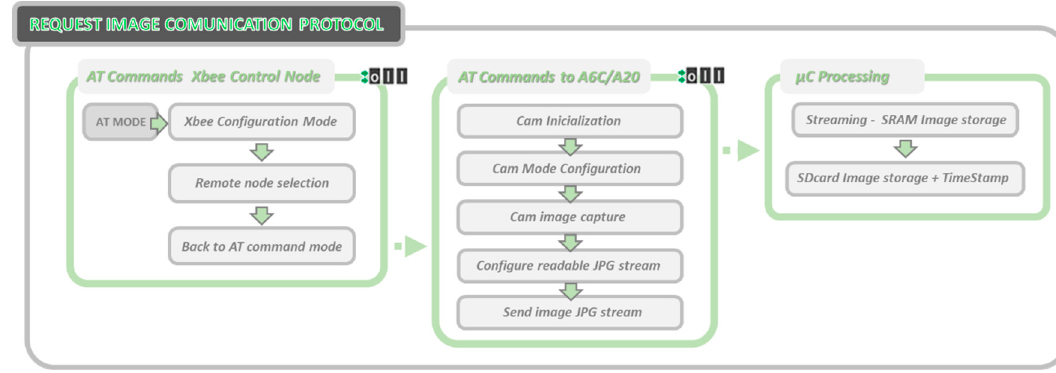
Figure 8. Steps of the protocol for image request and transmission.